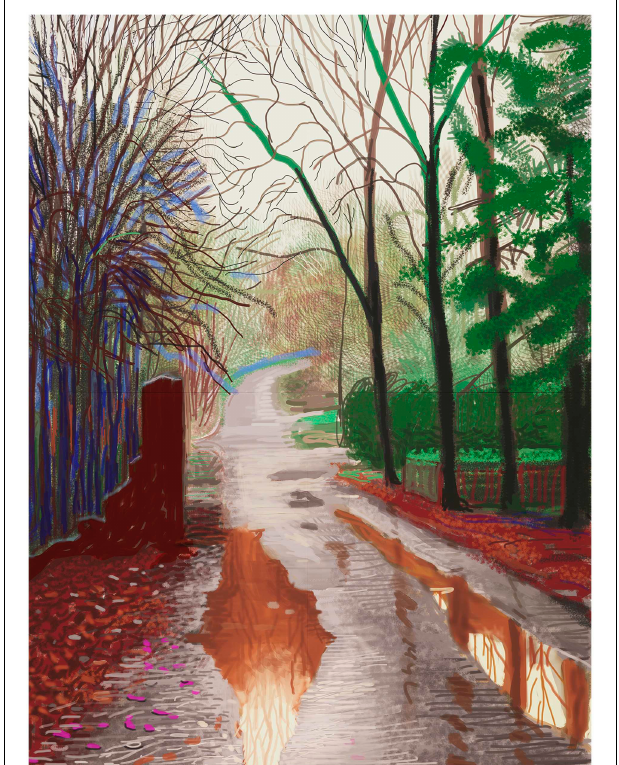
FIGURE 4 | Pablo Picasso, Bull’s Head (Tête de Taureau), 1942, Leather and metal, 33. 5 × 43 . 5 × 19 cm, Collection Musée Picasso, Paris. © Succession Picasso. Photo © RMN-Grand Palais (musée Picasso de Paris)/Béatrice Hatala. DACS, London 2015.